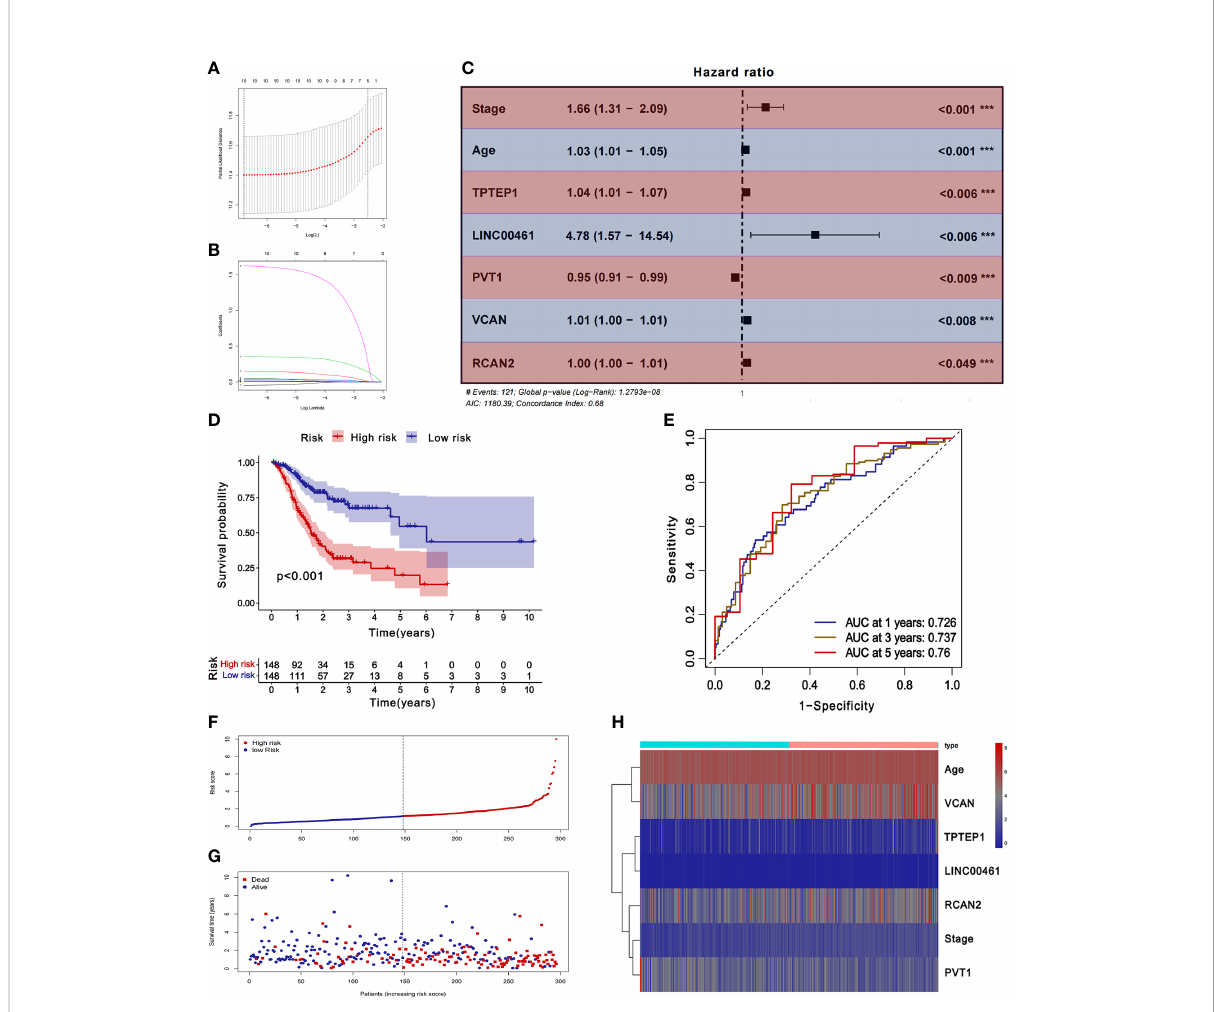
FIGURE 3 Construction and validation of ceRNA related prognostic model. (A, B) Lasso regression analysis was used to simplify the prognostic model. (C) Correlation between ceRNAs and prognosis. (D) K-M survival analysis of prognostic model. (E) ROC curve of prognostic model. (F-H) Survival status of gastric cancer patients with different risk